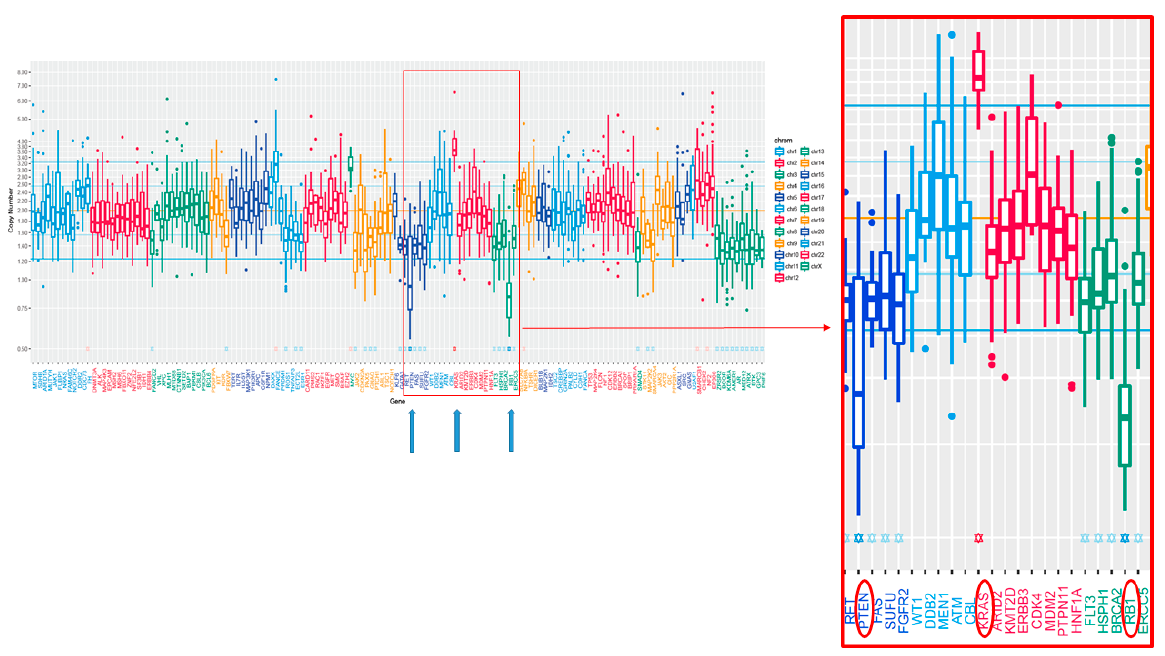
Figure 5. Copy number plot of cancer-related 160 genes. The horizontal axis indicates chromosomal location of the examined genes, and the vertical axis indicates the calculated copy number of each gene. The blue arrow indicated the amplification of KRAS and homodeletion of PTEN and RB1 .